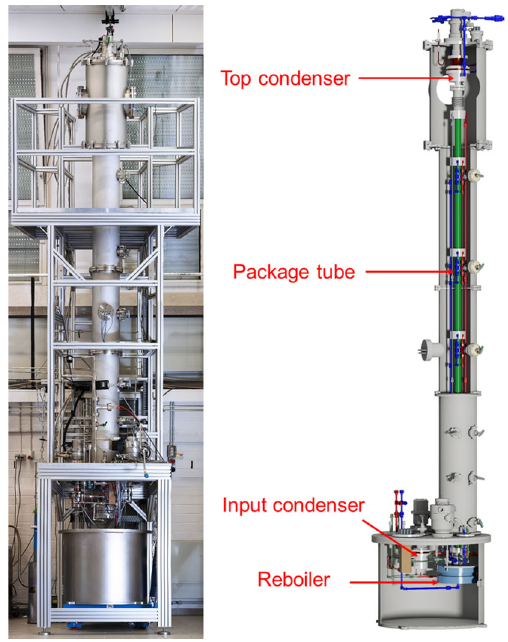
Fig. 6 Phase-2 setup during commissioning at WWU Münster. The final height is about 5.5m. The system was transferred and remounted at the underground laboratory LNGS in